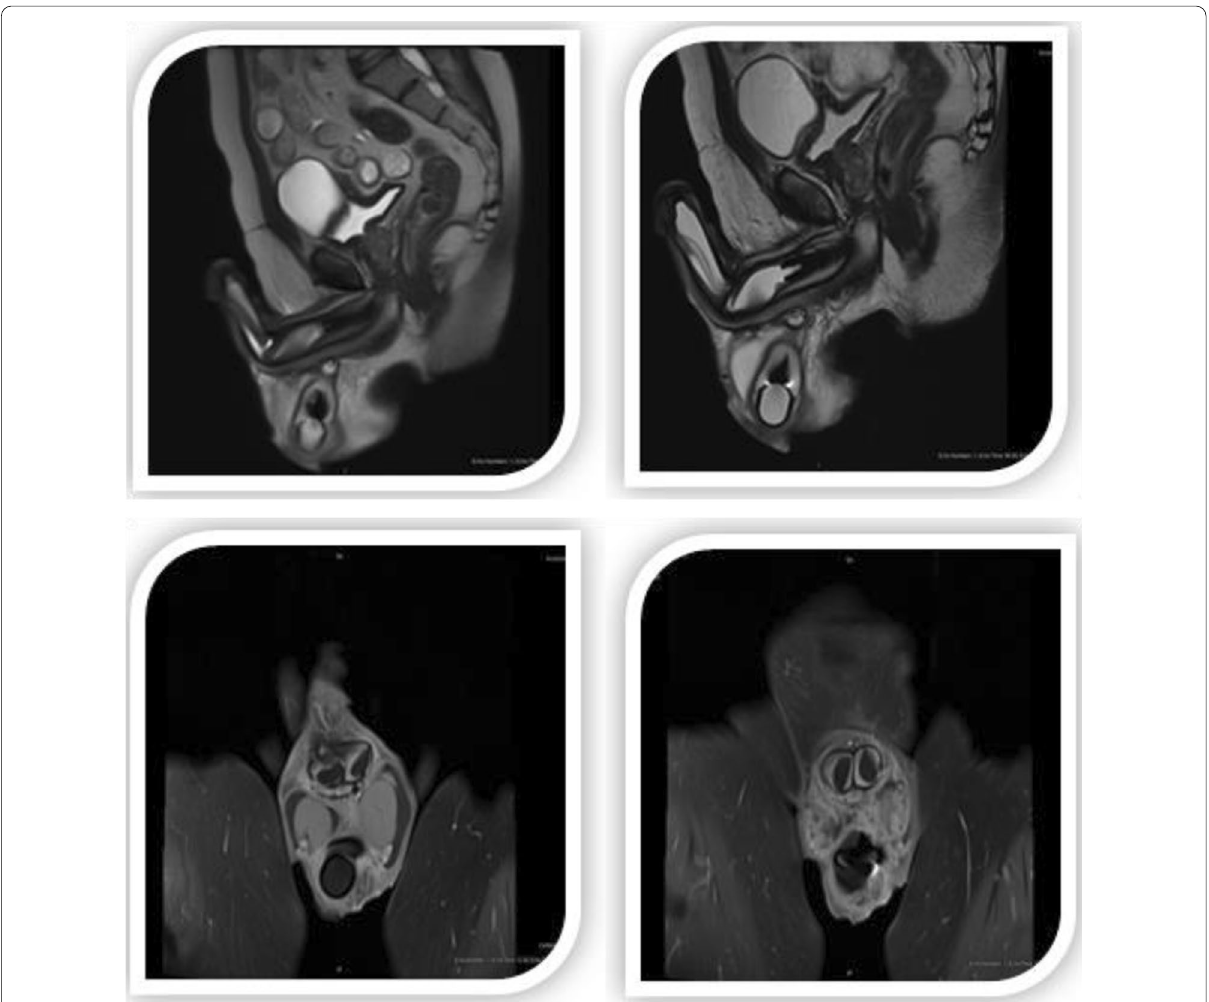
Fig. 5 MRI pictures showing significant soft tissue enhancement seen in scrotal soft tissue, tunica albuginea, around the pump and